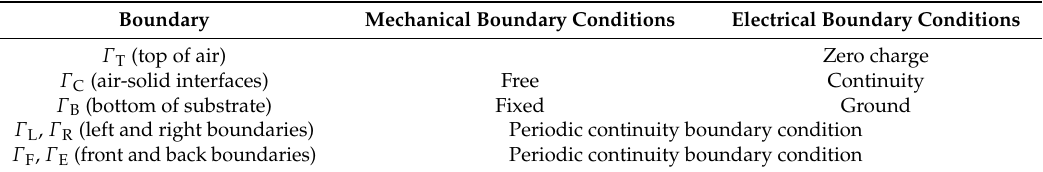
Table 2. Boundary conditions of the